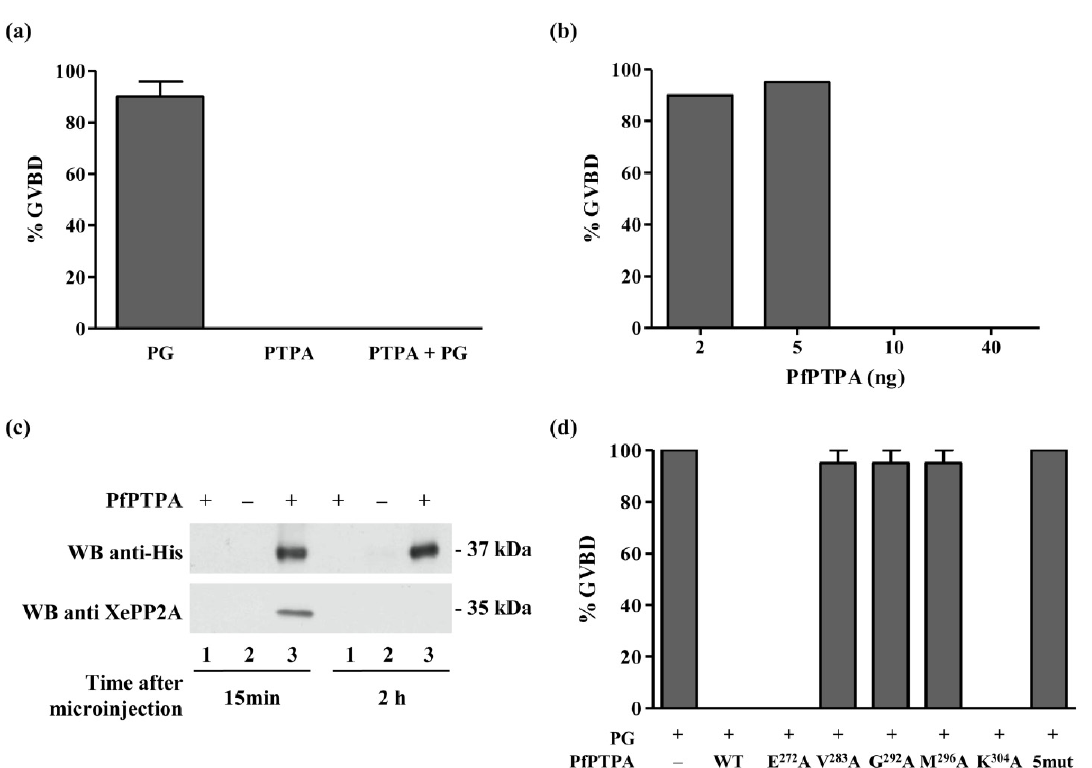
Figure 6. Inhibition of G2/M transition of Xenopus oocytes by PfPTPA. ( a ) Percentage of GVBD induced by the progesterone (PG), PfPTPA or the microinjection of PfPTPA followed by PG incubation; ( b ) Percentage of GVBD induced by PG incubation after microinjection of different amount of PfPTPA; ( c ) Binding of PfPTPA with XePP2A in Xenopus oocytes. Co-immunoprecipitation experiment of the PfPTPA-XePP2A complex with anti-His antibodies (recognizing recombinant PfPTPA tagged with 6-His) (lanes 2 and 3) from microinjected Xenopus oocytes. The anti-mouse IgG antibody (lanes 1) was used as a control. Immunoprecipitates from Xenopus oocytes microinjected with water ( − ) or PfPTPA (+) were eluted, separated by SDS-PAGE and transferred to nitrocellulose membrane. Immunoblot analysis was performed with anti-His antibodies (recognizing PfPTPA) (upper panel) or anti-XePP2A antibodies (lower panel); ( d ) Effect of PfPTPA on progesterone-dependent GVBD in Xenopus oocytes. Percentage of GVBD induced by